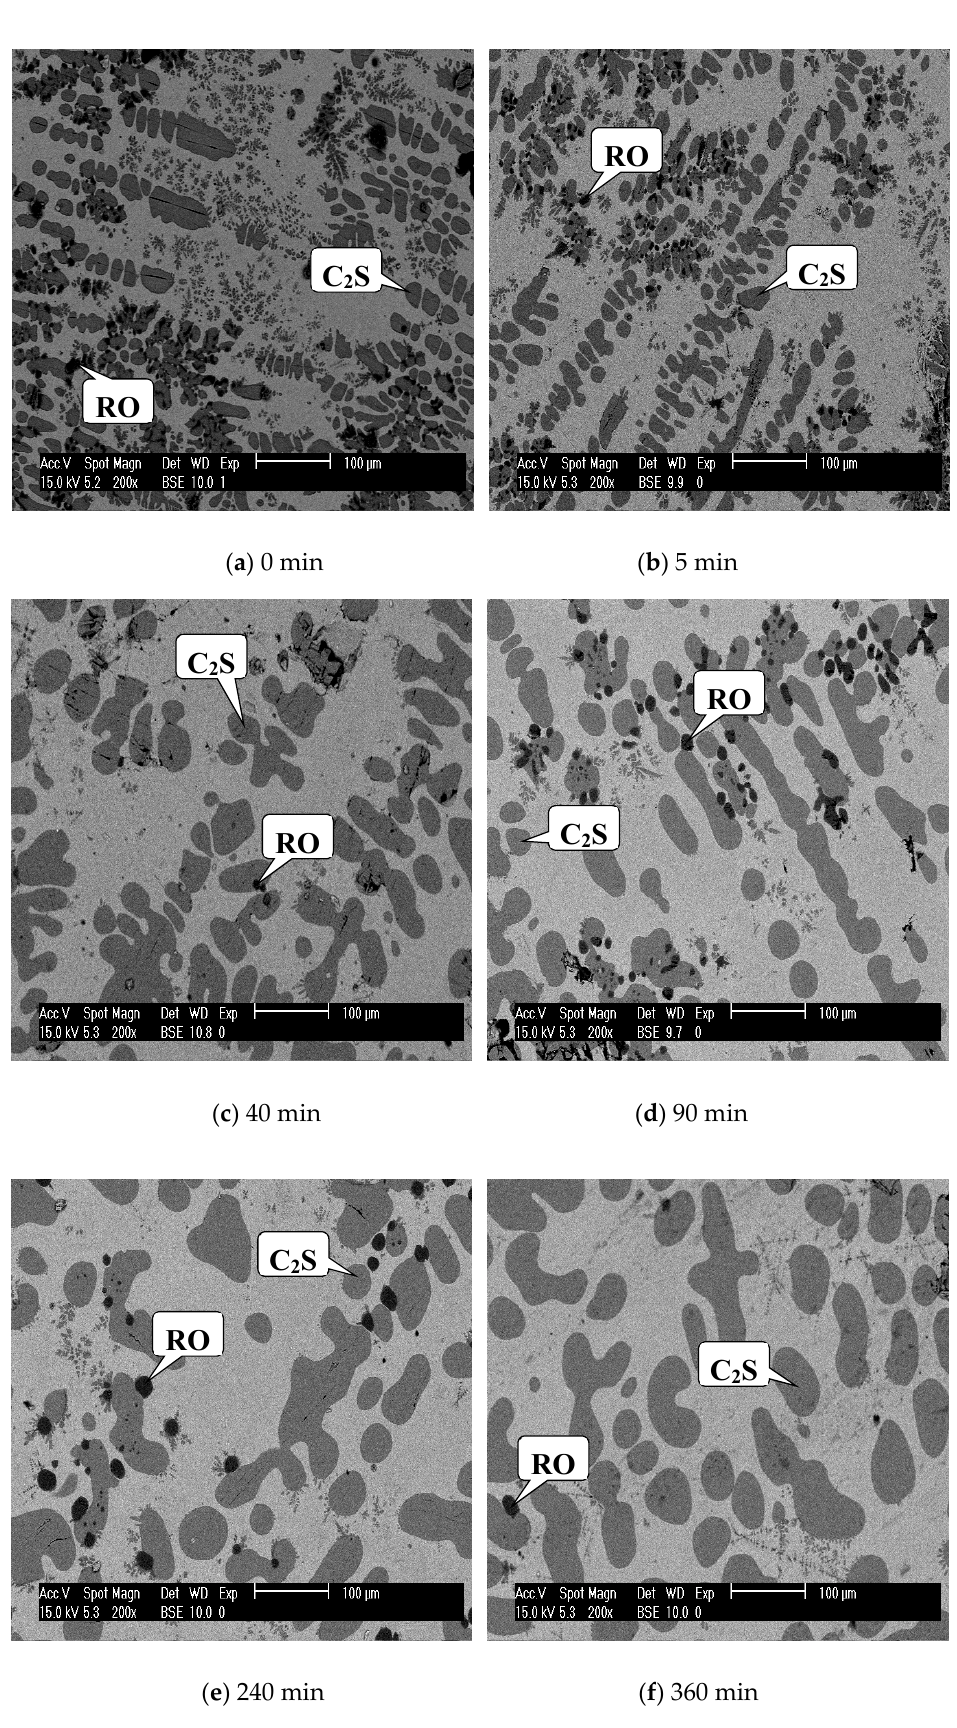
Figure 1. SEM images of the modified slag with different holding times at 1673 K. Table 2. EDS analysis of the modified slag with different holding times at 1673 K (at%).